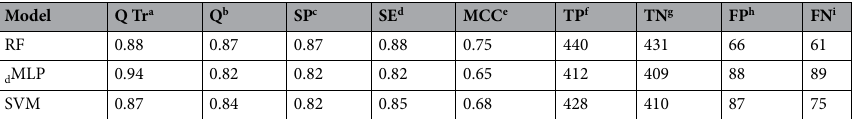
Analysis of important molecular attributes.